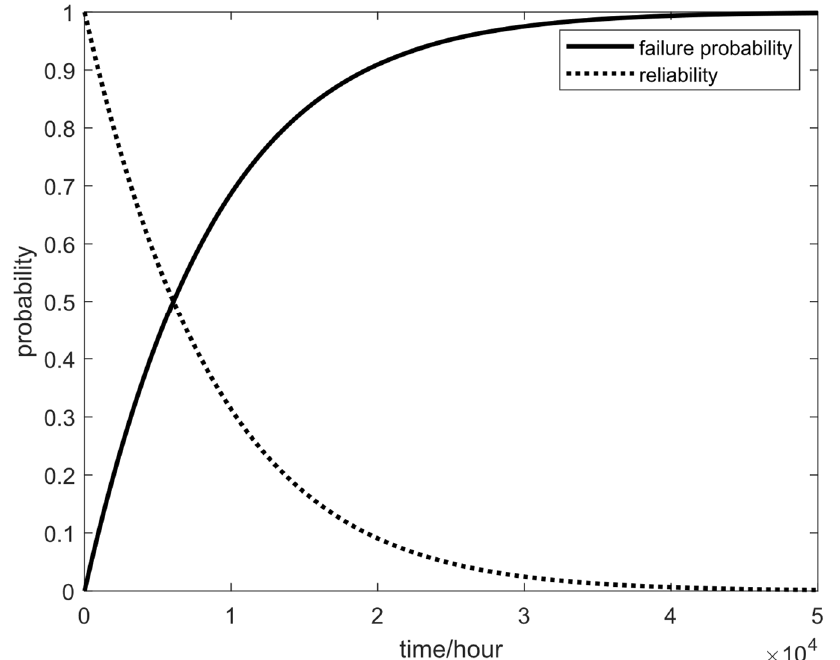
Figure 5. Reliability change for automotive airbag systems.